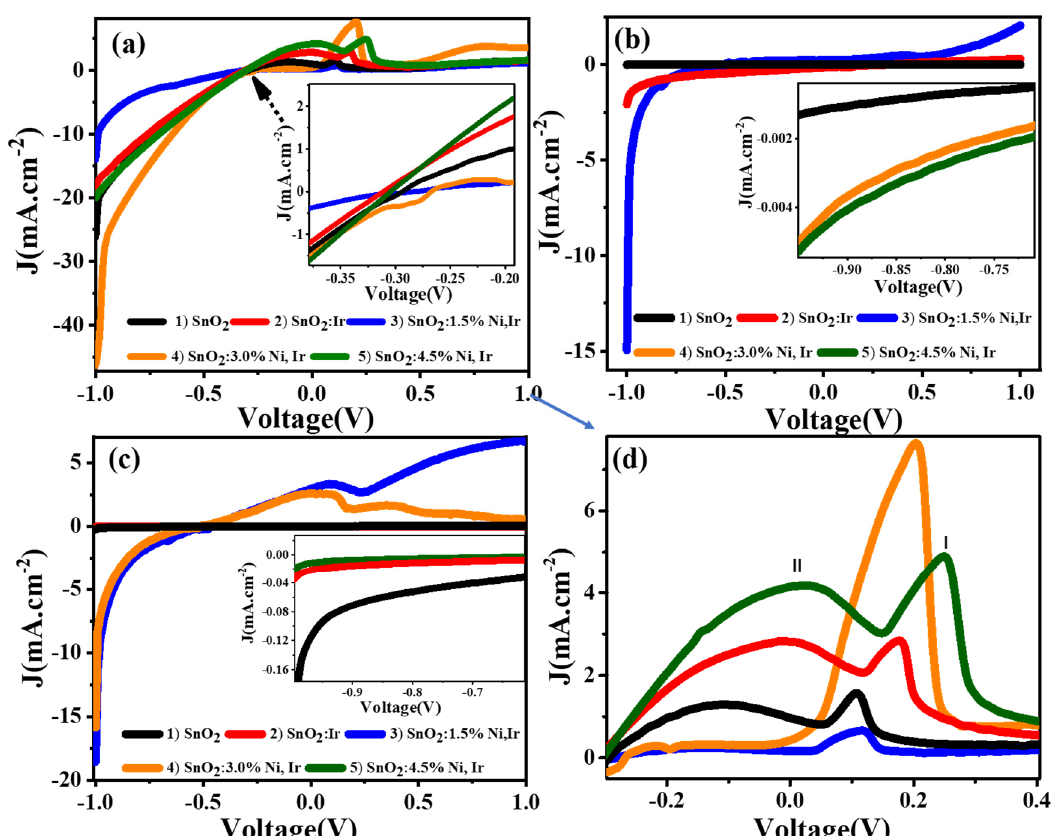
Figure 5. Electrodes’ photocurrent density–voltage curves in 100 mL of 0.5 M ( a ) HCl; ( b ) Na 2 SO 4 ; ( c ) NaOH; and ( d ) anodic current density versus voltage of peak I and peak II. The insets of ( a ),( b ), and ( c ) represent enlarged parts of the photocurrent density–voltage curves.